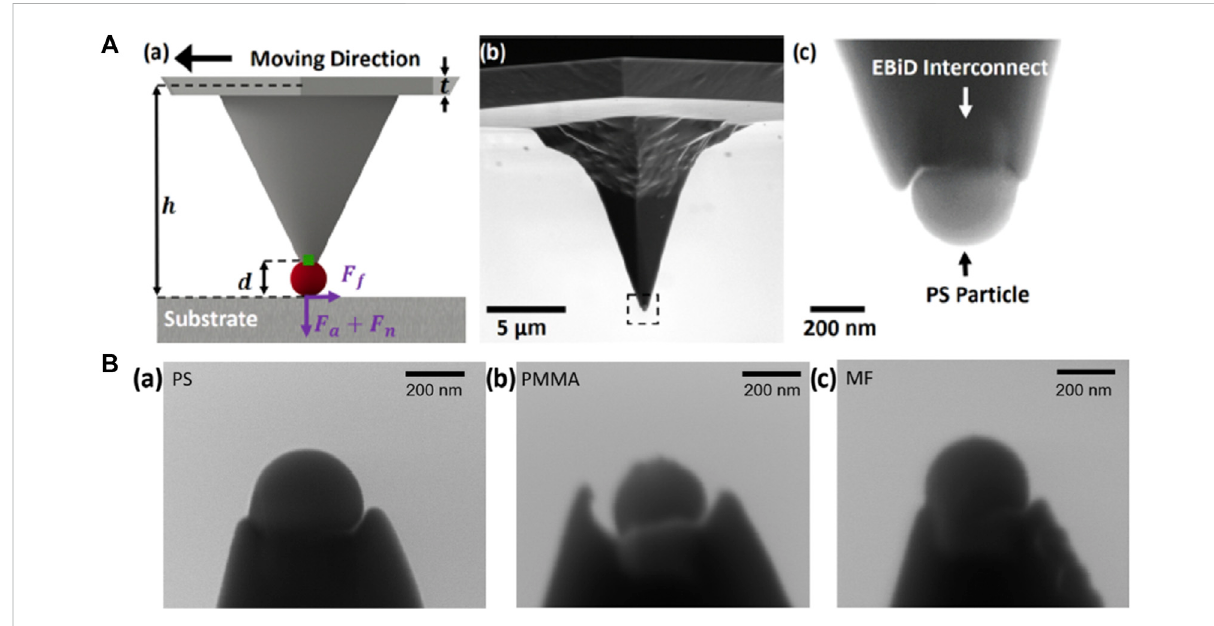
FIGURE 4 (A) Schematic representation of the forces acting on a laterally sensitive colloidal probe during a friction test, and an SEM micrograph of a laterally sensitive colloidal probe with a PS particle that has been fastened to the tip apex via EBiD of a tungsten-based precursor gas; (B) SEM micrographs of PS, PMMA, and MF nanoparticles after conducting AFM-based adhesion and friction testing. Reprinted with permission from (Zimmermann et al., 2020) Copyright 2020 American Chemical